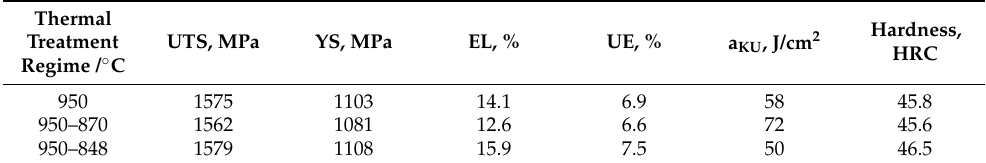
Table 1. Mechanical properties of the test steel under different heat treatment process. Thermal Treat-